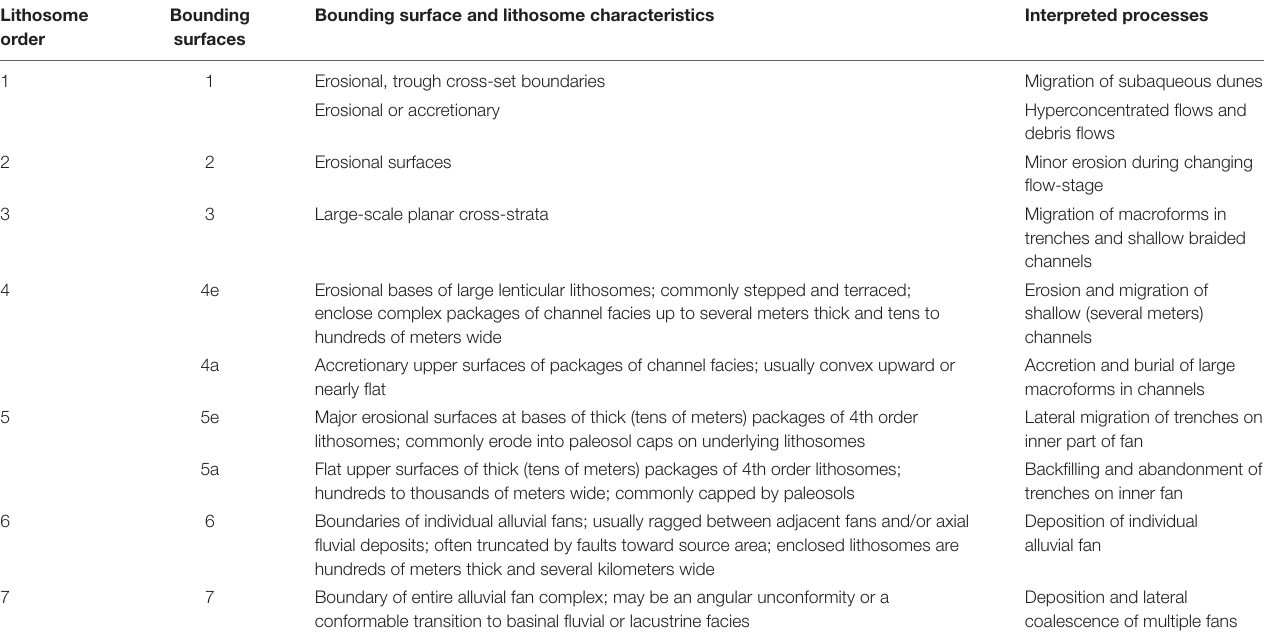
TABLE 1 | Summary of the hierarchy of lithosomes and bounding surfaces in alluvial